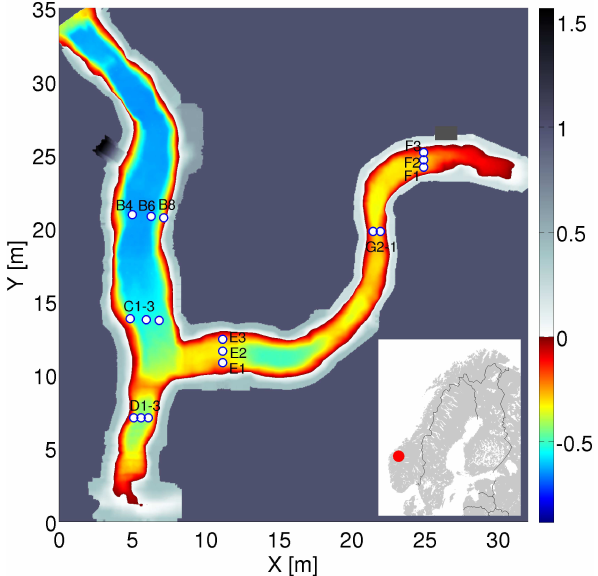
Figure 1. Applied bathymetry derived from lidar measurements of the scale model of Storfjorden. A subset of the time series gauges that concur with the resistant wave gauges reported in Lind- strøm et al. (2014) are also depicted. The location of the landslide source in the experiments of Lindstrøm et al. (2014) is north of the B gauges ( Y = 25m). The inset indicates the geographical location of the fjord that the 1:500 scale model is